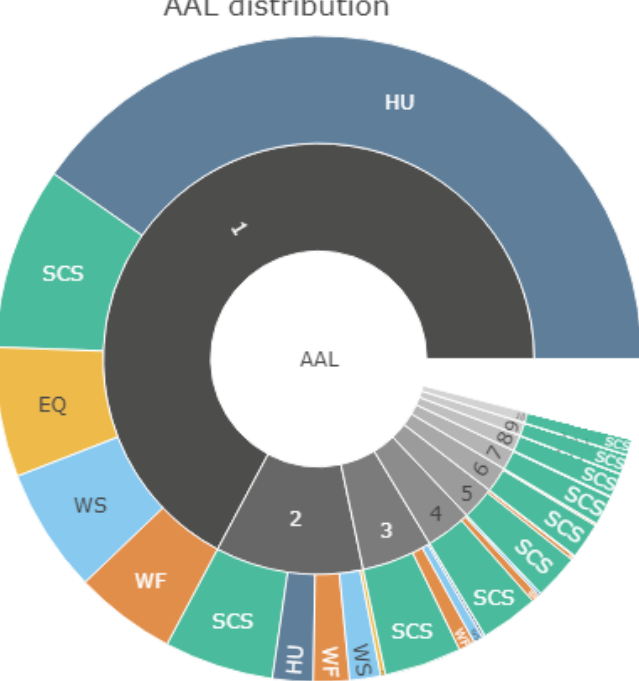
Figure 5. The decomposition of the pre-catXL AAL. The inner gray shaded circle displays (in proportion to the arc length) the contributions of the various occurrence loss orders to the full AAL. The color shaded segments with associated peril name abbreviations displays the contributions, to each occurrence loss order, of the individual perils. For example, the contribution of HU to order M = 1 is over 50